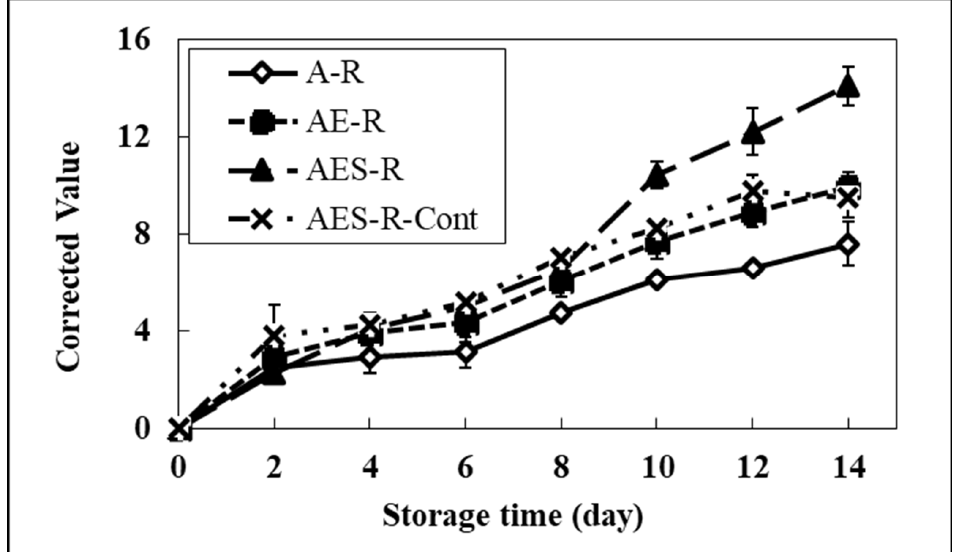
Figure 5 . Redness (“a”) of model systems containing resazurin for 14 days. Note that it was used for calibrating our system. A-, AE-, and AES- stand for agar, agar and emulsifier, and agar, emulsifier, and soybean oil, respectively. AES-R-Cont represents AES-R system covered with pure GBF. Bars indicate the standard deviation.